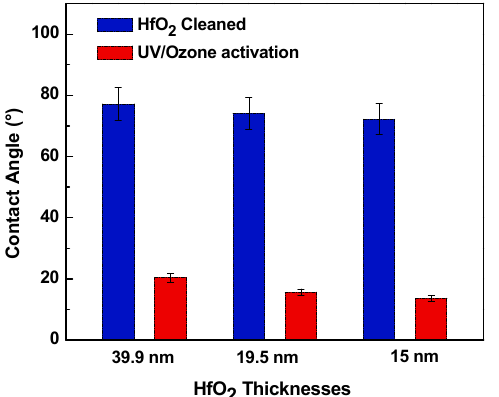
Figure 2. Contact angle measurements of the HfO 2 surface for the three thicknesses of 15.0, 19.5 and 39.9 nm used for the pH sensor based on Al/Si/SiO 2 /HfO 2 .